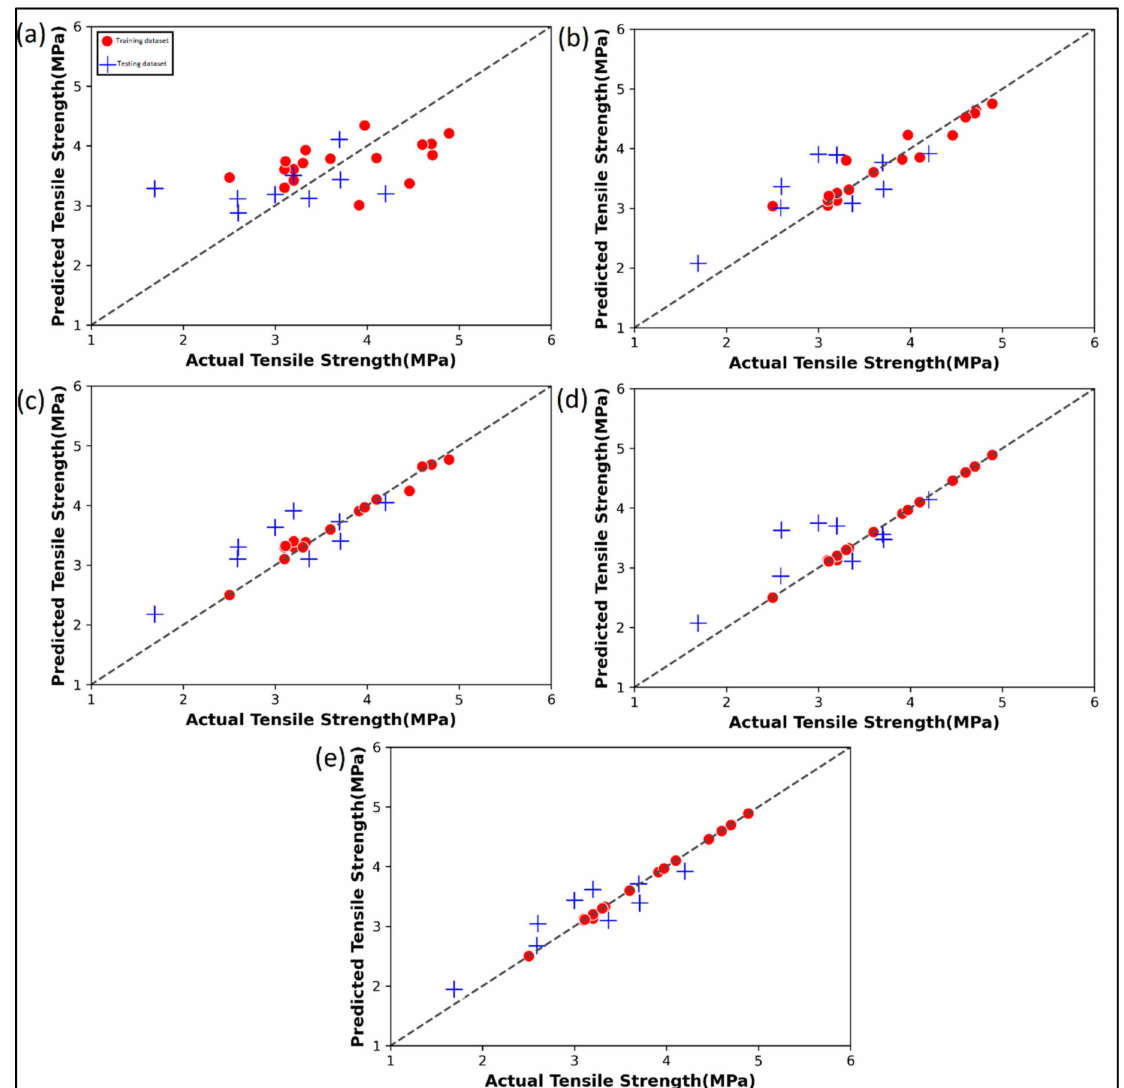
Figure 7. Actual versus predicted tensile strength by various ML algorithms: ( a ) Linear regression; ( b ) Random Forest regression; ( c ) AdaBoost regression; ( d ) Gradient boost regression; ( e ) XG Boost regression for case study